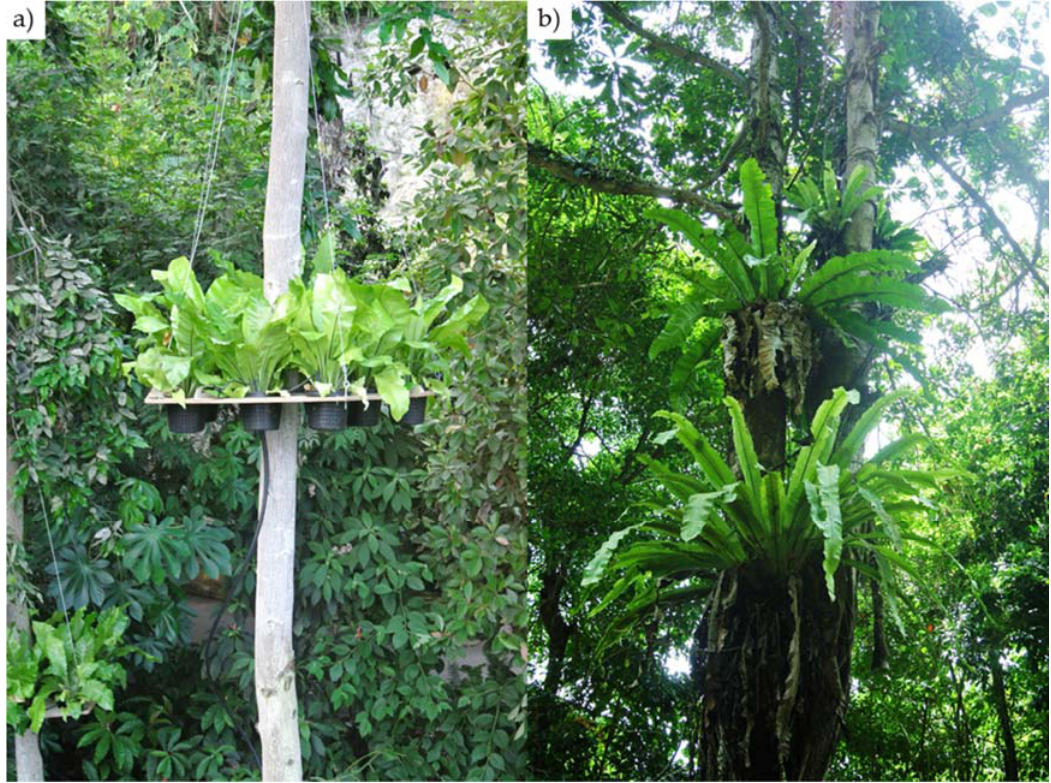
Figure 1. Asplenium bird’s nest ferns in ( a ) the rain forest biome at the Eden Project, Cornwall, U.K.; ( b ) Danum Valley, Sabah, Malaysian Borneo. ( b ) Danum Valley, Sabah, Malaysian